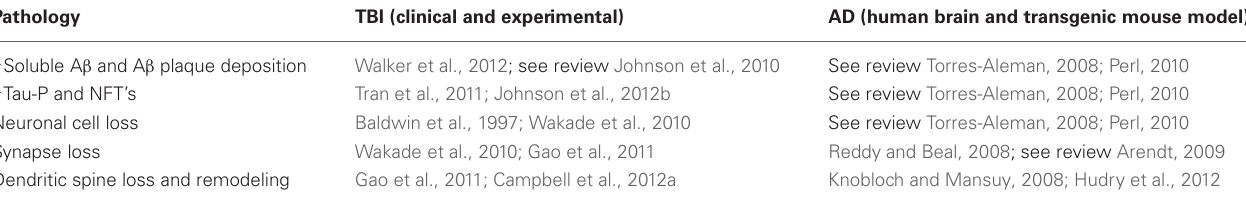
Table 1 | Common pathological features in TBI and